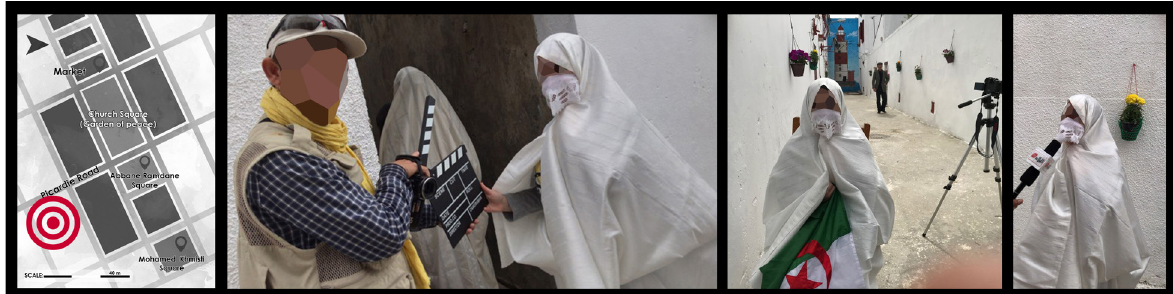
Fig. 6. Urban theatricalities around the shooting of a music clip – City Centre, May 21st, 2019. Source: Khelfallah